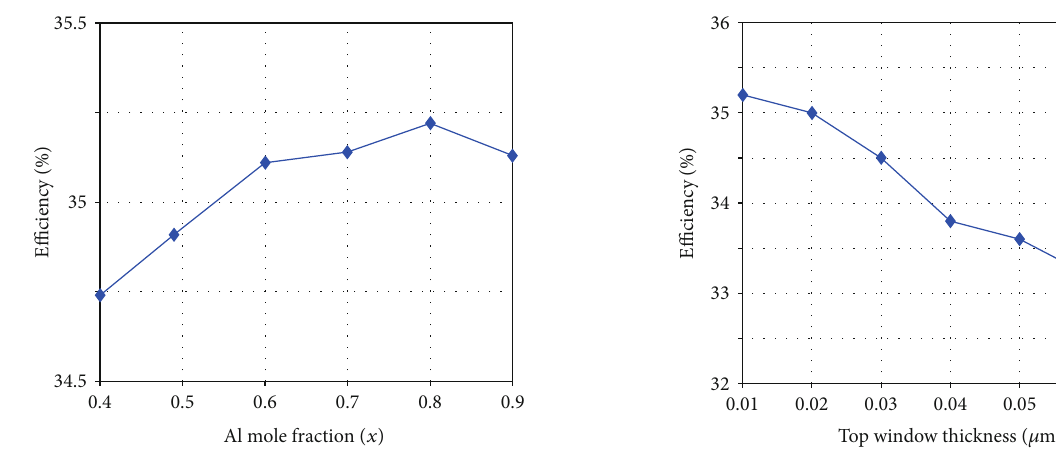
Figure 2: DJ solar cell e ffi ciency for the six values of the Al mole fraction.